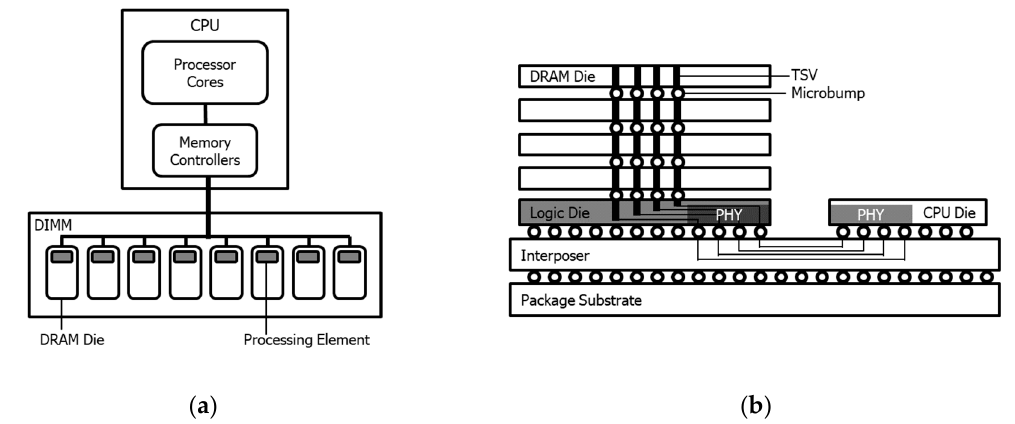
Figure 1. In-memory computing structure examples: ( a ) 2D planar DRAM, such as DIMM type, and ( b ) 3D stacked DRAM, such as HBM type.